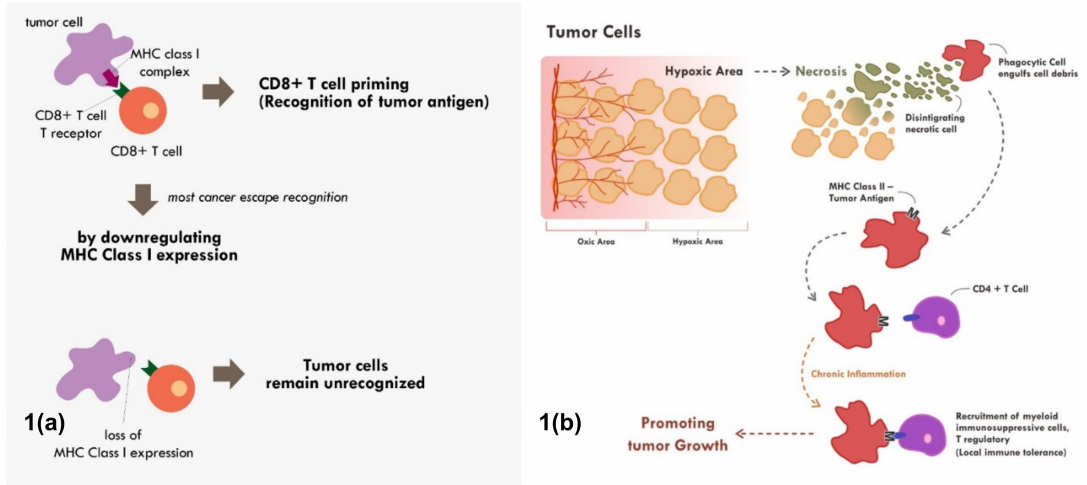
Figure 1. Mechanisms of tumor escape immune recognition. ( a ) Through downregulation of MHC Class I in tumor cells, rendering tumor cells unrecognized. ( b ) Through engulfment of tumor debris and further presentation through MHC Class II and APC cells (chronic process of that event leads to chronic inflammation resulting in sensitization and di ff erentiation of CD4 + T cells toward immune suppressive CD4 + T regulatory cells